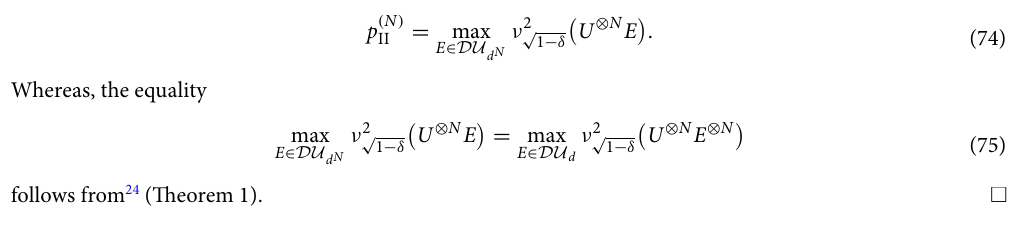
( U ⊗ N ) (ovals) of √ 1 δ 0.7 − =